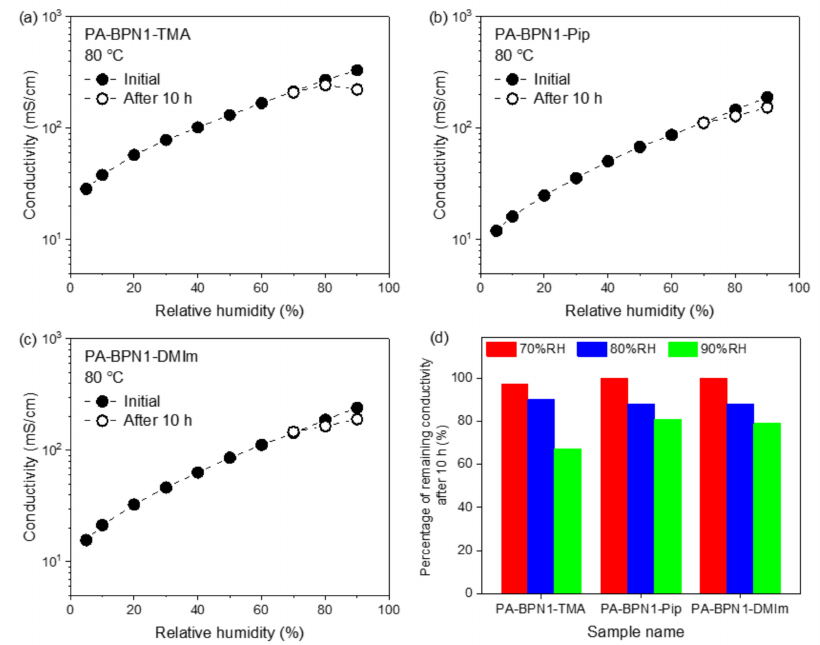
Figure 6. Conductivity durability tests of ( a ) PA-BPN1-TMA; ( b ) PA-BPN1-Pip; ( c ) PA-BPN1-DMIm; and ( d ) the percentage of remaining conductivity after holding samples at 80 ◦ C under 70% RH, 80% RH and 90% RH, respectively, for 10